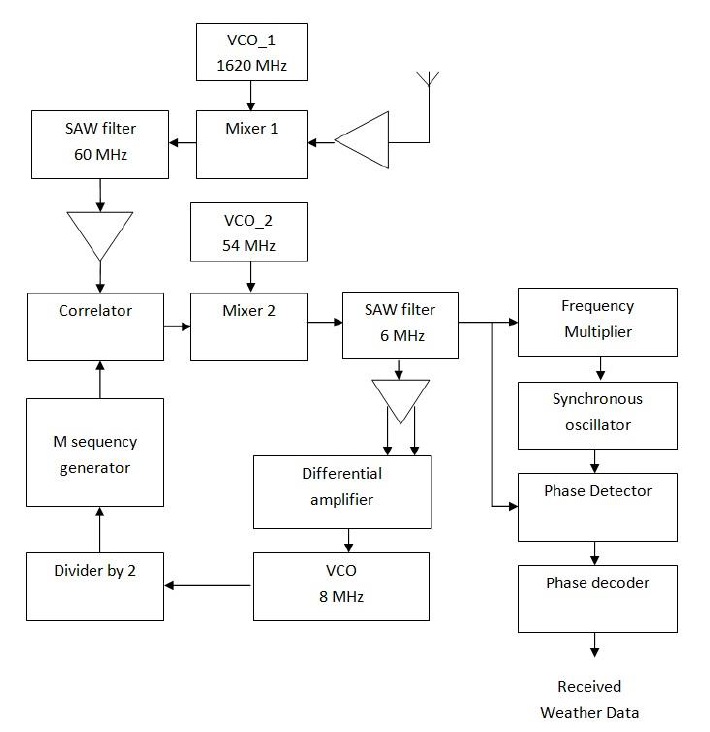
Fig. 3. Block diagram of the receiving device radar spread spectrum